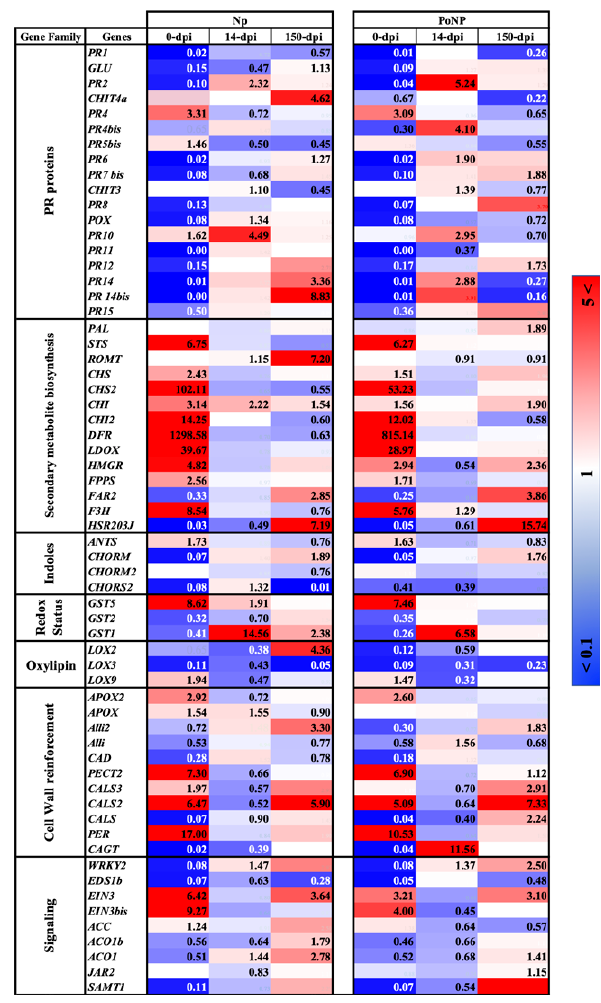
Figure 6. Relative expression levels of 62 defence genes in grape- vine wood 0 ,14 or 150 days after inoculations. Gene expression of mock-control plants was used as reference to calculate the relative expression. Each column represents the time point after inocula- tion treatments (Np = Neofusicoccum parvum and PoNp = Pythium oligandrum + N. parvum ), and each line corresponds to one gene, represented by a single row of boxes. The colour scale bars repre- sent the ratio values corresponding to the mean of three independ- ent samples. Up-regulated genes are shown in shades of red, with relative expression levels greater than 5 in bright red. Down-regu- lated genes are shown in shades of blue, with relative expression less than 0.1 in dark blue. Numbers in boxes represent the significant changes ( P < 0.05; Kurskall-Wallis test) in gene expression com- pared to the mock-control. Np = N. parvum , PoNp = P. oligandrum + N. parvum